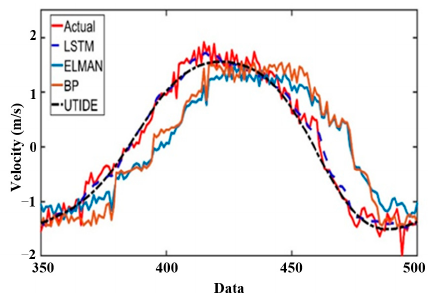
Figure 15. Enlarged figure of the comparison results in Figure 14.